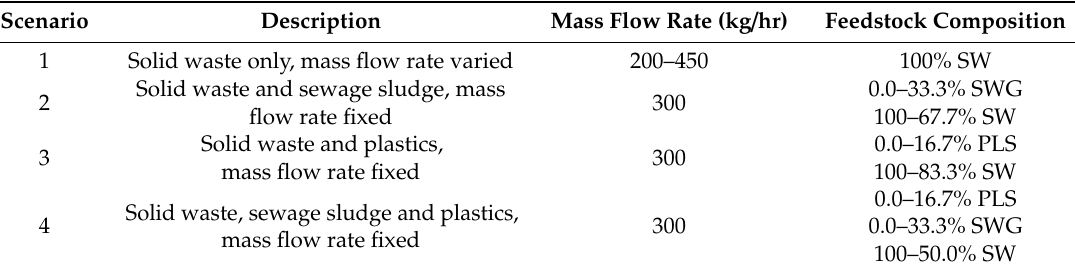
Table 5. Scenarios